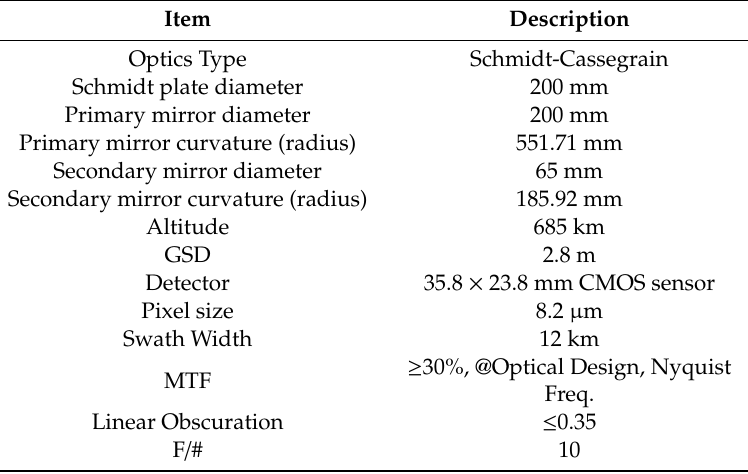
Table 1. Conceptual optical system